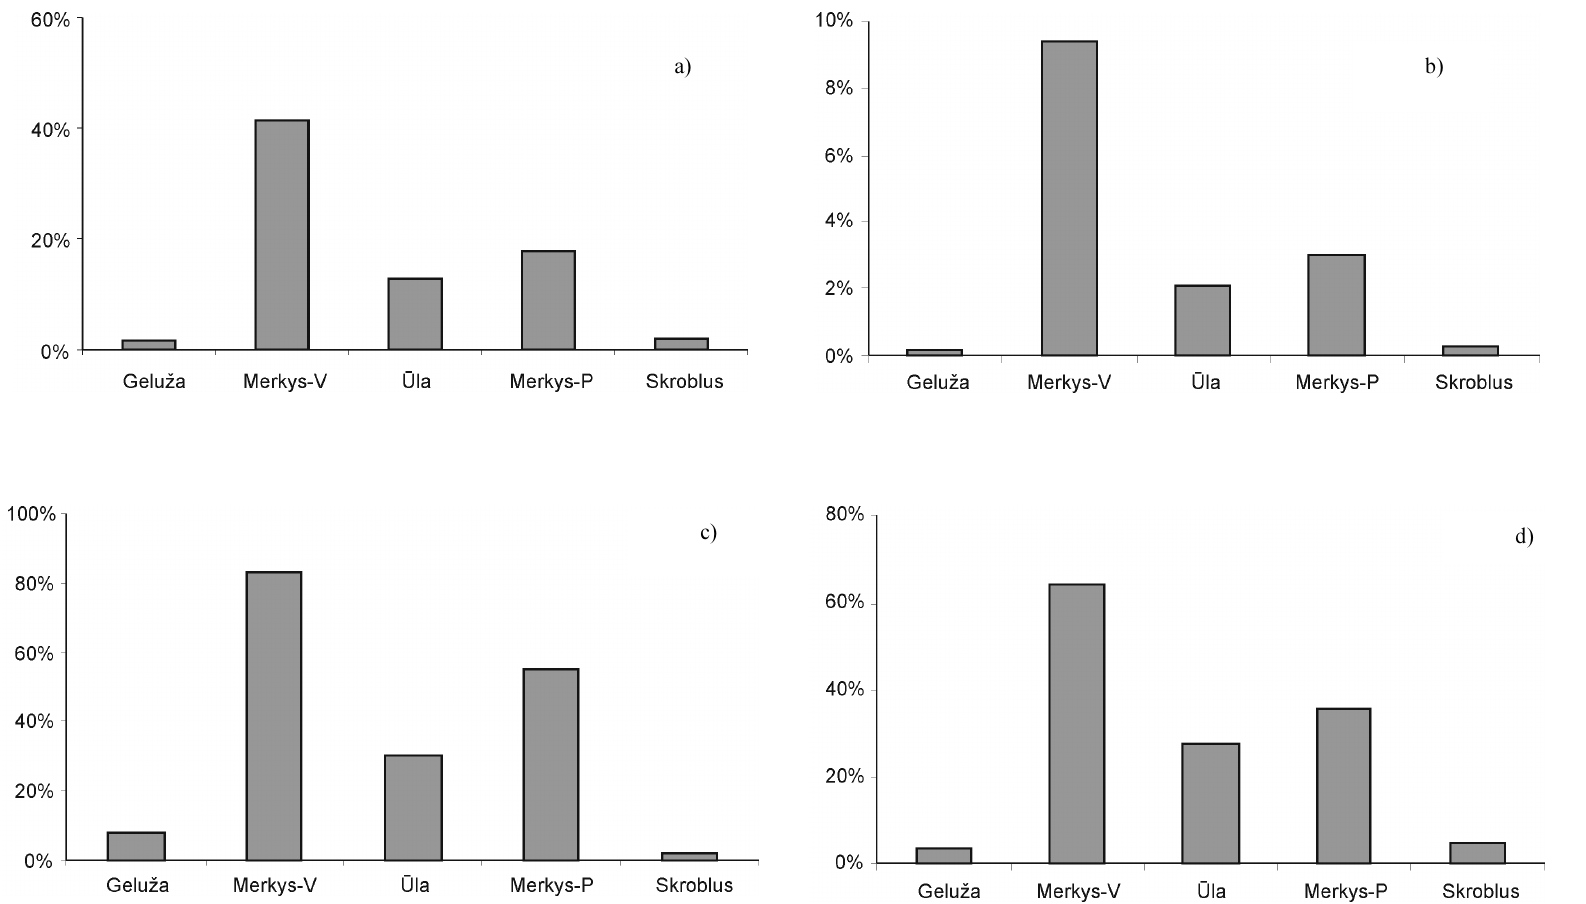
Fig. 5. Retention of COD (a), BOD (b), total nitrogen (c) and total phosphorus (d) in studied